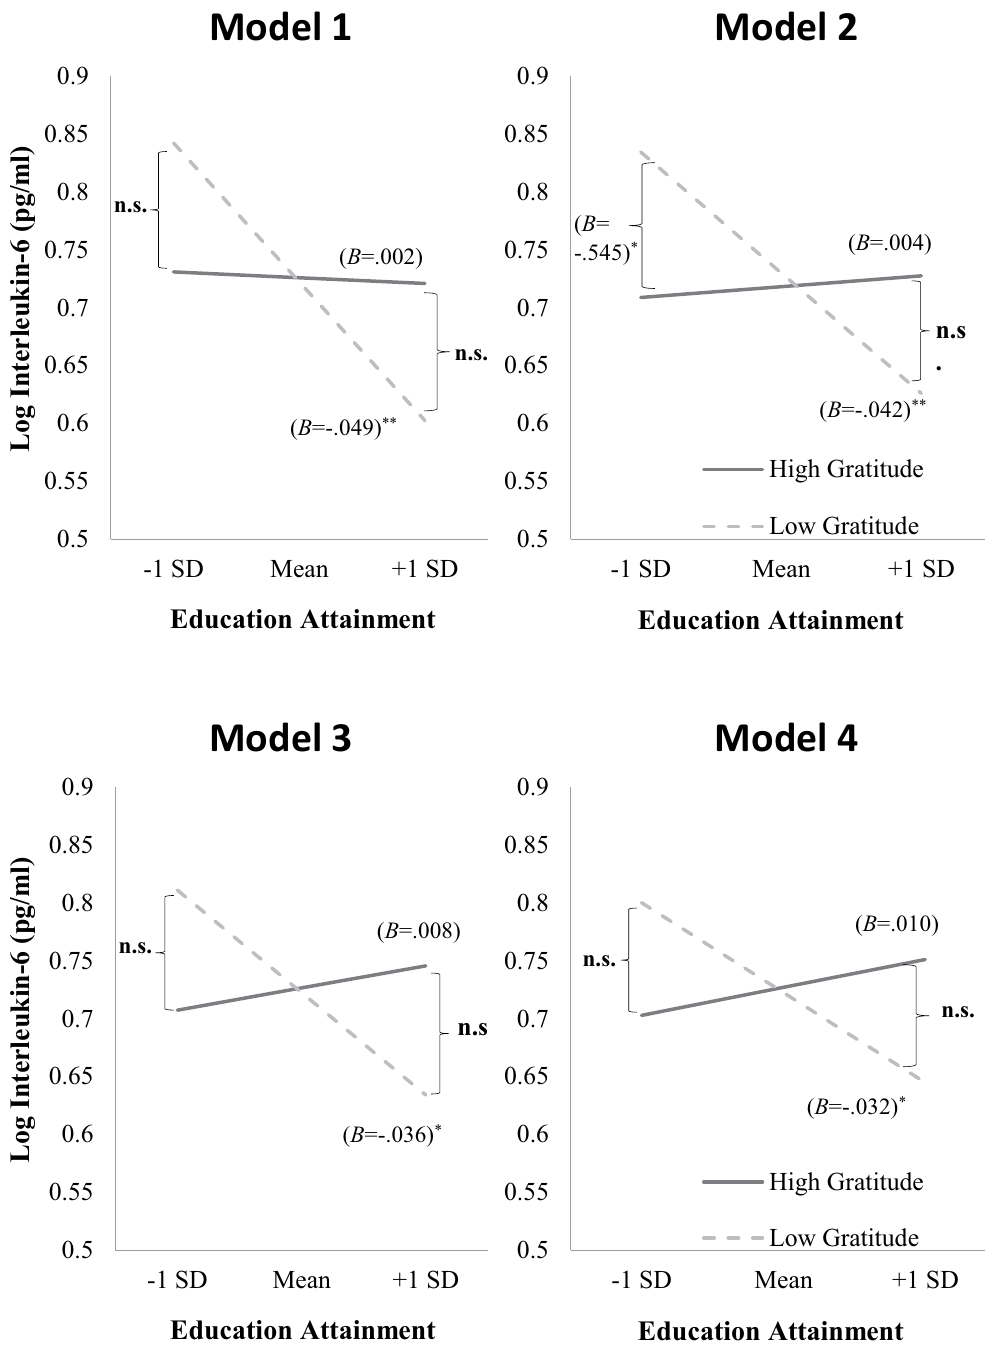
Figure 1. Simple slopes (i.e., unstandardized coefficients) of education attainment predicted interleukin-6 when trait gratitude was 1 SD above and below the mean across the four models (adjusted and unadjusted models). n.s. = not significant. * p < 0.05, ** p <